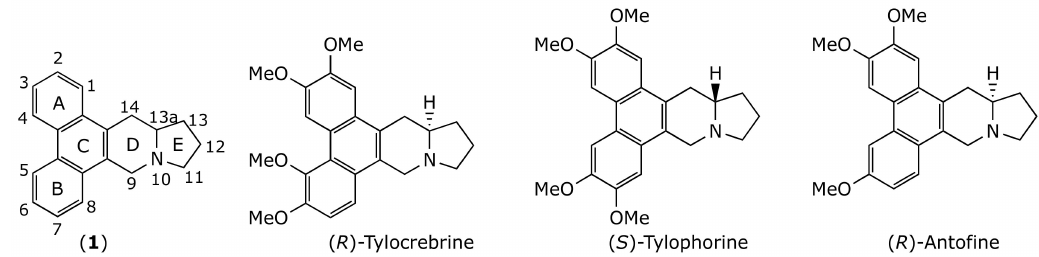
Figure 1. Chemical structure of some phenanthroindolizidine